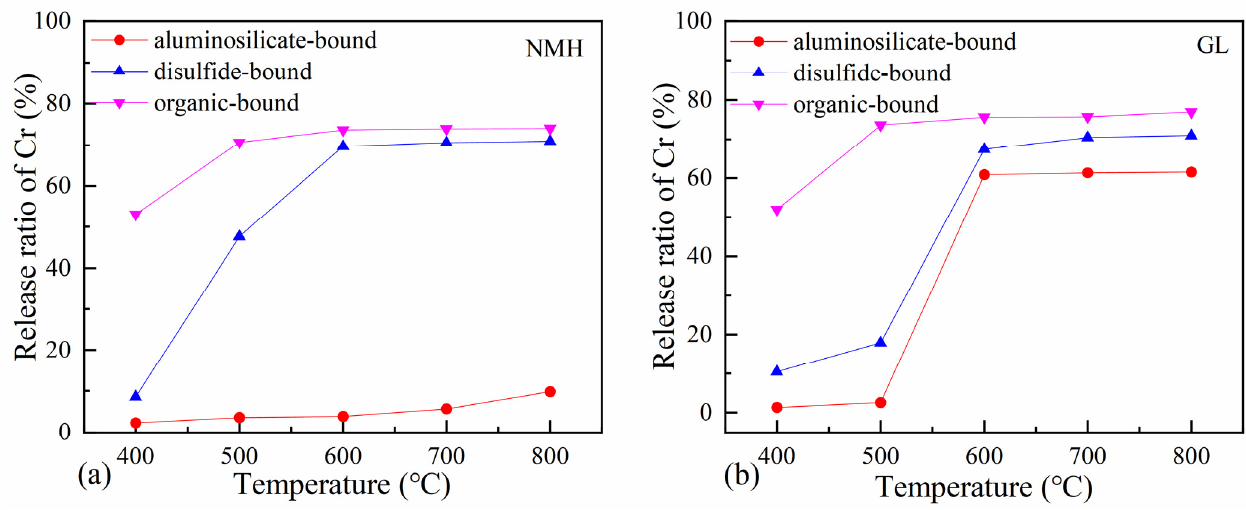
Figure 7. Release behavior of Cr in different SCS of NMH ( a ) and GL ( b ).